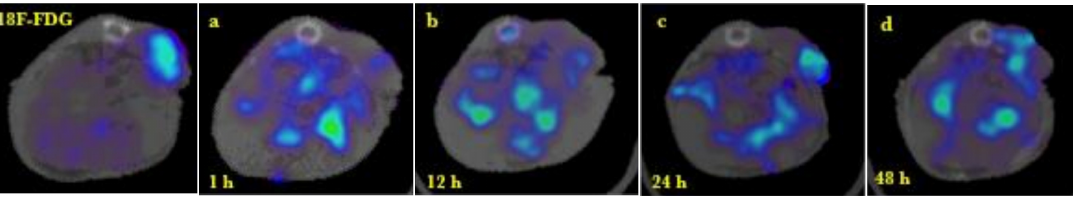
Figure 2. Left: The 18 FDG PET/CT image denotes the metabolic activity of a mesothelioma xenograft. Images a – d : 67 Ga-nimotuzumab SPECT/CT shows nimotuzumab uptake in the tumor at 1, 12, 24, and 48 h post-injection. All images show transversal projections based on the tumor position of the same animal at different